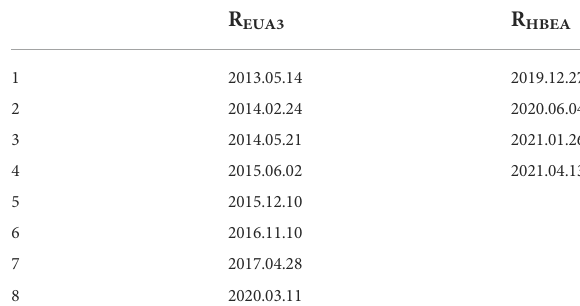
TABLE 7 Structural breaks of EUA futures and Hubei spot